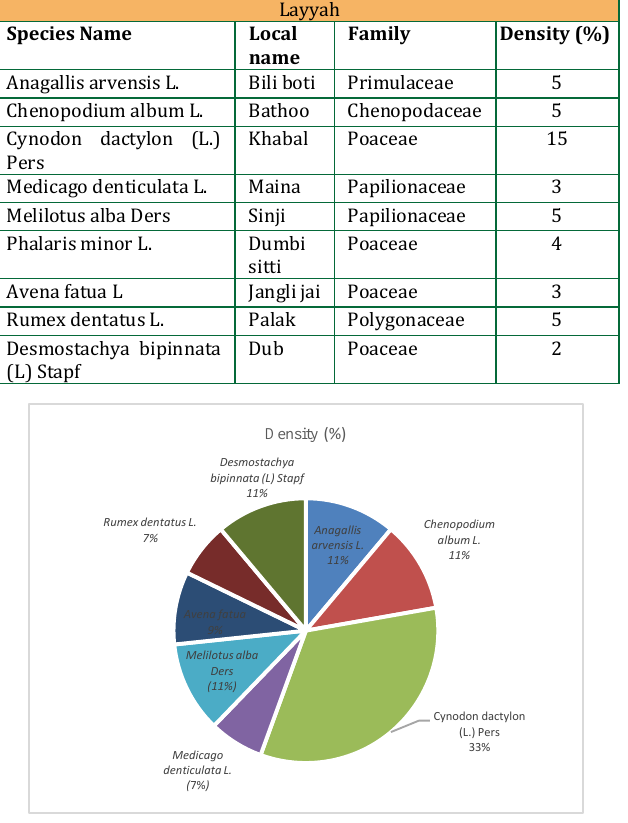
Figure 2: Density of weed infesting wheat fields in Nawan Kot site.